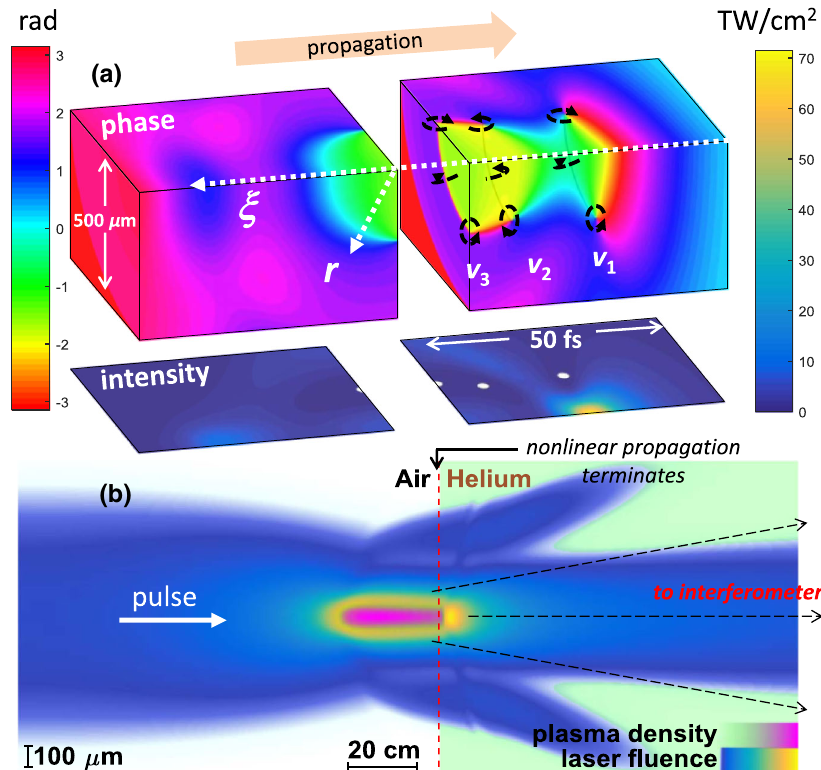
FIG. 1. (a) Phase and intensity projections of simulated pulse, in local coordinates, showing STOV generation. Propagation medium: atmospheric pressure air. Black dashed lines encircle vortices v 1 , v 2 , and v 3 , and arrows point in the direction of increasing phase. Our phase winding convention considers a ð ξ − ξ 0 Þ þ i ð r − r 0 Þ winding about a null at ( ξ 0 , r 0 ) to denote a þ 1 STOV, giving the v 1 STOVa þ 1 charge. The white dots in the intensity projection are centered on the locations of vortices v 1 , v 2 , and v 3 . (b) Simulation of an air filament crossing the air-helium boundary for the conditions of (a), showing the beam fluence and plasma density. Nonlinear propagation terminates as the beam transitions from air to helium, whereupon the beam and a reference pulse (not shown; see Appendix A) are directed to an